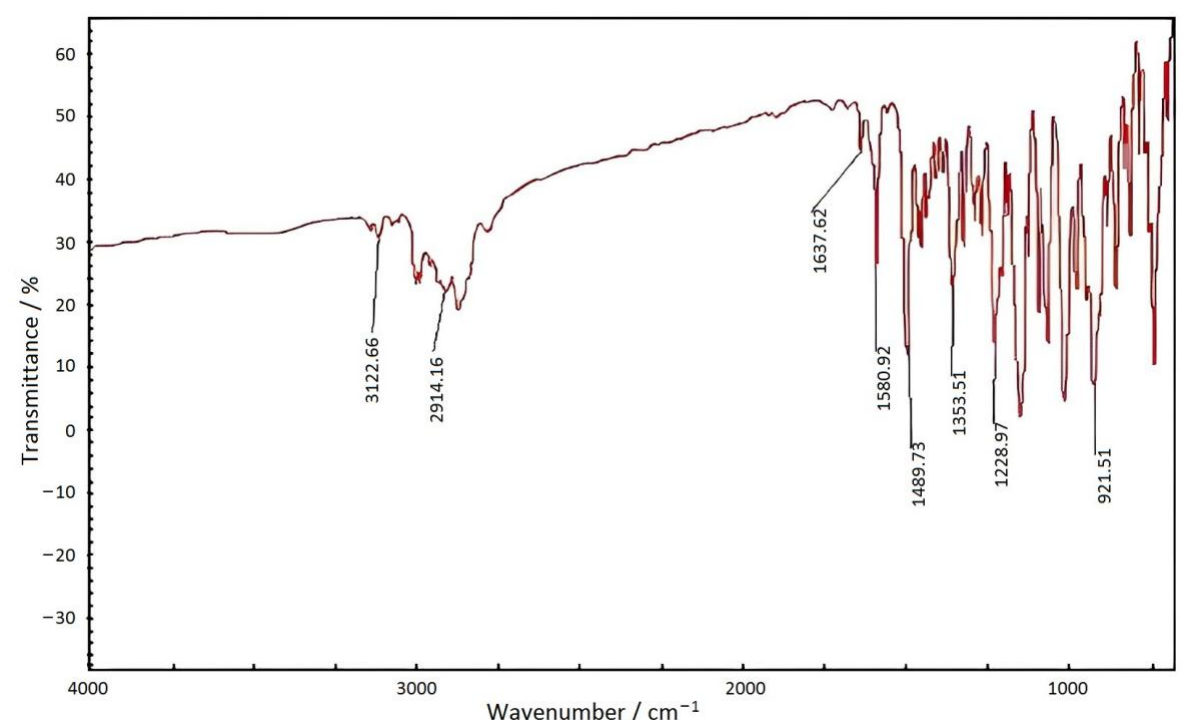
Figure 5. FTIR spectrum of benzoxazine (eugenol). Table 4. The result of FTIR spectrum of benzoxazine (eugenol)